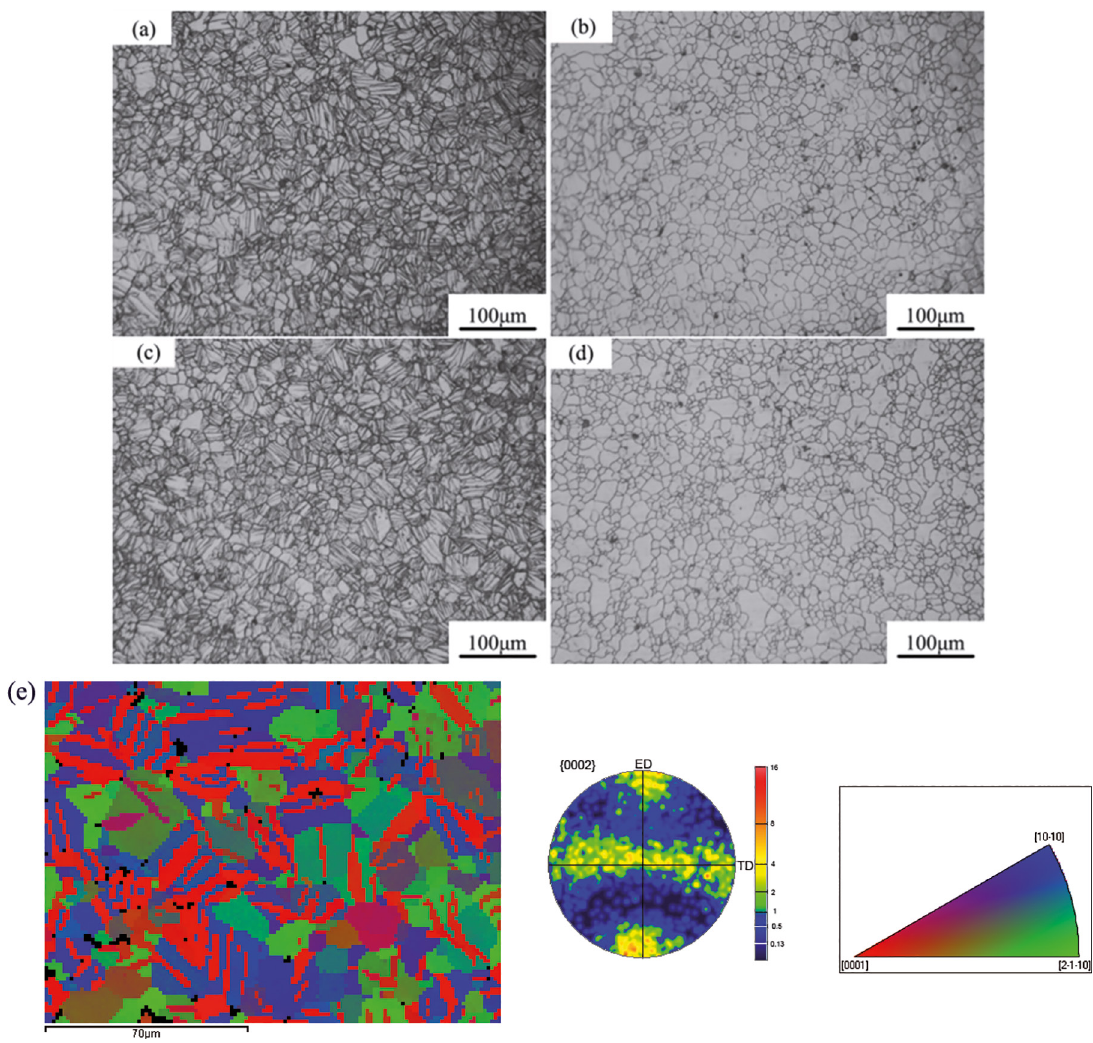
Figure 5. Evolution of microstructures during pre-compression on AZ31 Mg alloy billets: (a) 1st prc3%, (b) 1st inverse tension 3%, (c) 2nd prc 3%, (d) tensile to fracture, (e) EBSD maps of 1st prc3% specimens.